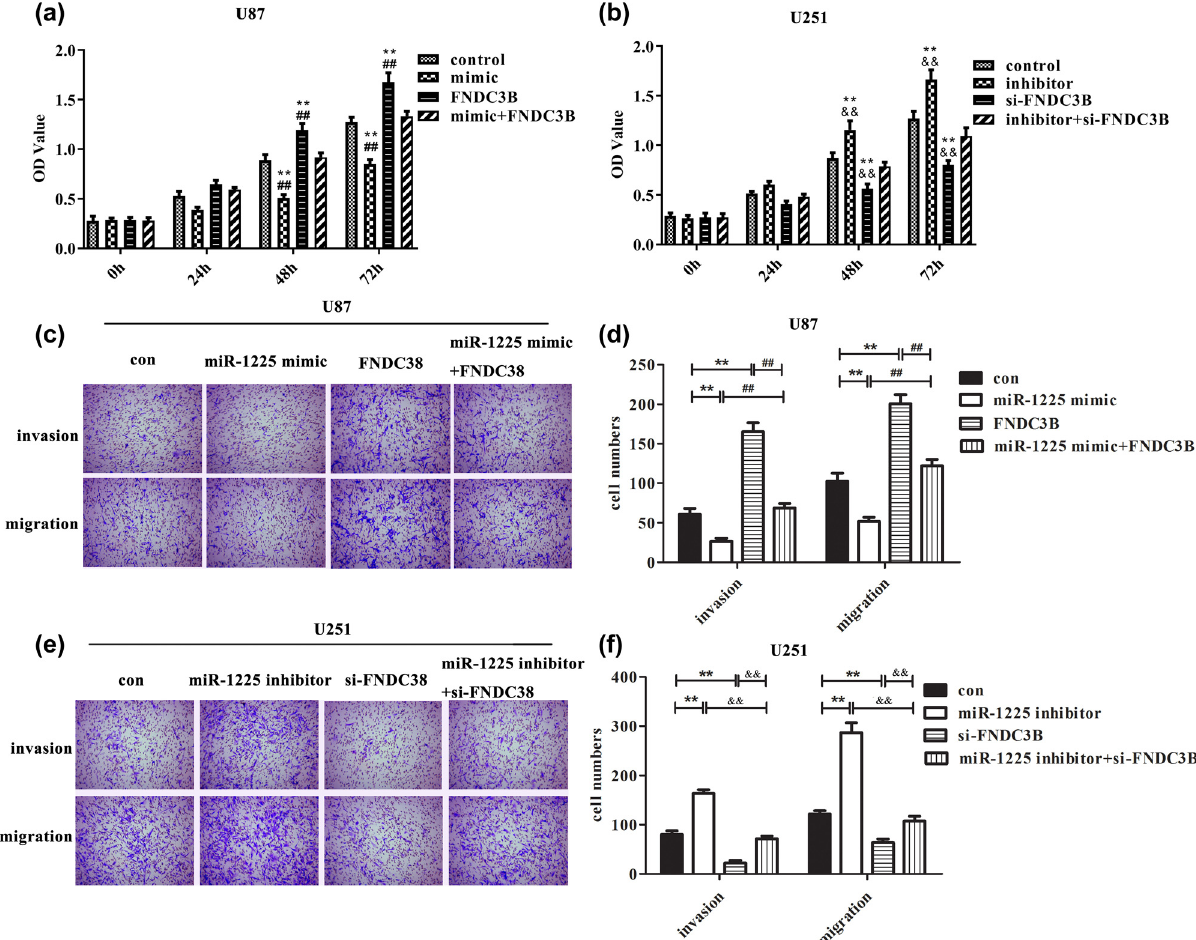
Figure 6: The e ff ect of miR - 1225 - 5p/FNDC3B axis on the malignant phenotype of glioblastoma cells. CCK - 8 and Transwell assay were performed to measure the e ff ect of miR - 1225 - 5p/FNDC3B axis on cell viability, invasion and migration. ( a, c and d ) U87 cells were transfected with miR - 1225 mimic, pcDNA3.1 - FNDC3B or miR - 1225 mimic + pcDNA3.1 - FNDC3B. ( b, e and f ) U251 cells were transfected with miR - 1225 inhibitor, si - FNDC3B or miR - 1225 inhibitor + si - FNDC3B. ** P < 0.01 vs control group. ## P < 0.01 vs miR - 1225 - 5p mimic + pcDNA3.1 - FNDC3B group. && P < 0.01 vs miR - 1225 - 5p inhibitor + si - FNDC3B